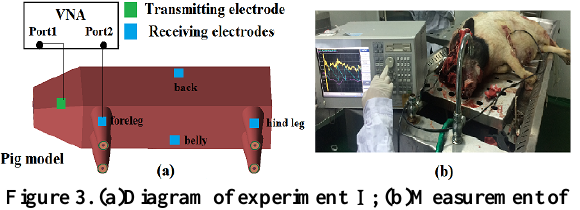
Figure 3. (a)Diagram of experiment Ⅰ ; (b)Measurement of amplitude and group delay via VNA .